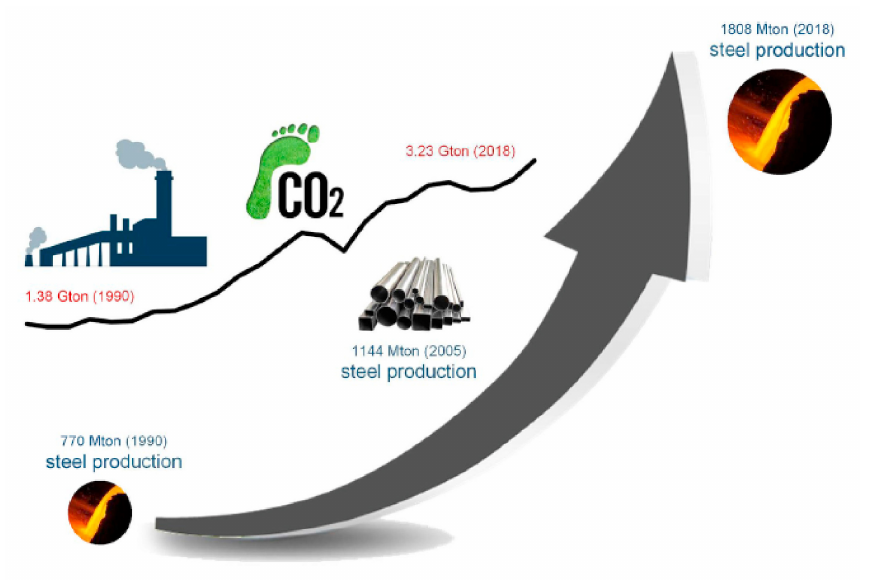
Figure 7. Worldwide steel production in 2018, along with the CO 2 emission, reprinted with permis- sion from ref. [34]. Copyright 2019 Elsevier